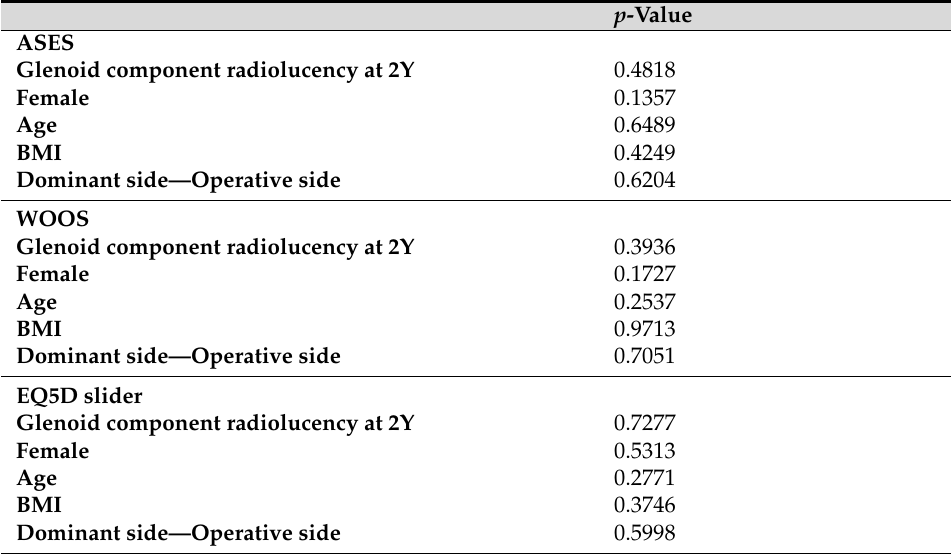
Table 5. Linear regression models for two-year PROMS.